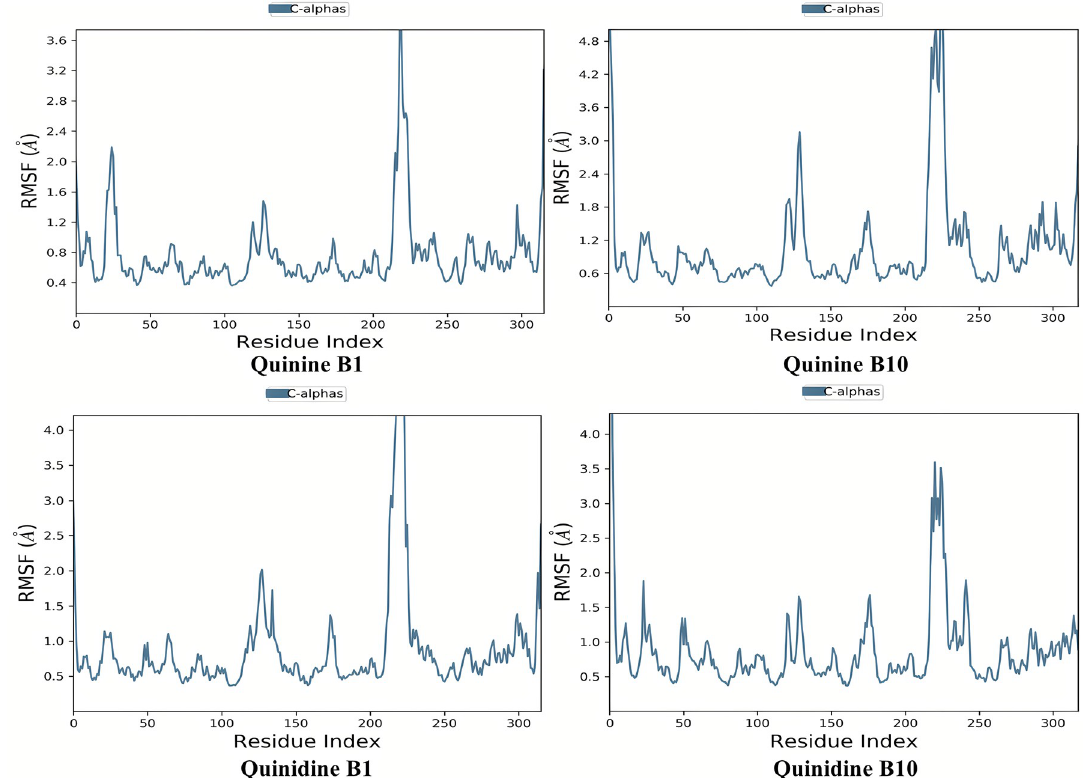
Fig 17. Residue wise Root Mean Square Fluctuation (RMSF) of the C-alpha atoms of AKR1B1-Quinine, Quinidine; AKR1B10-Quinine, Quinidine complexes with time.